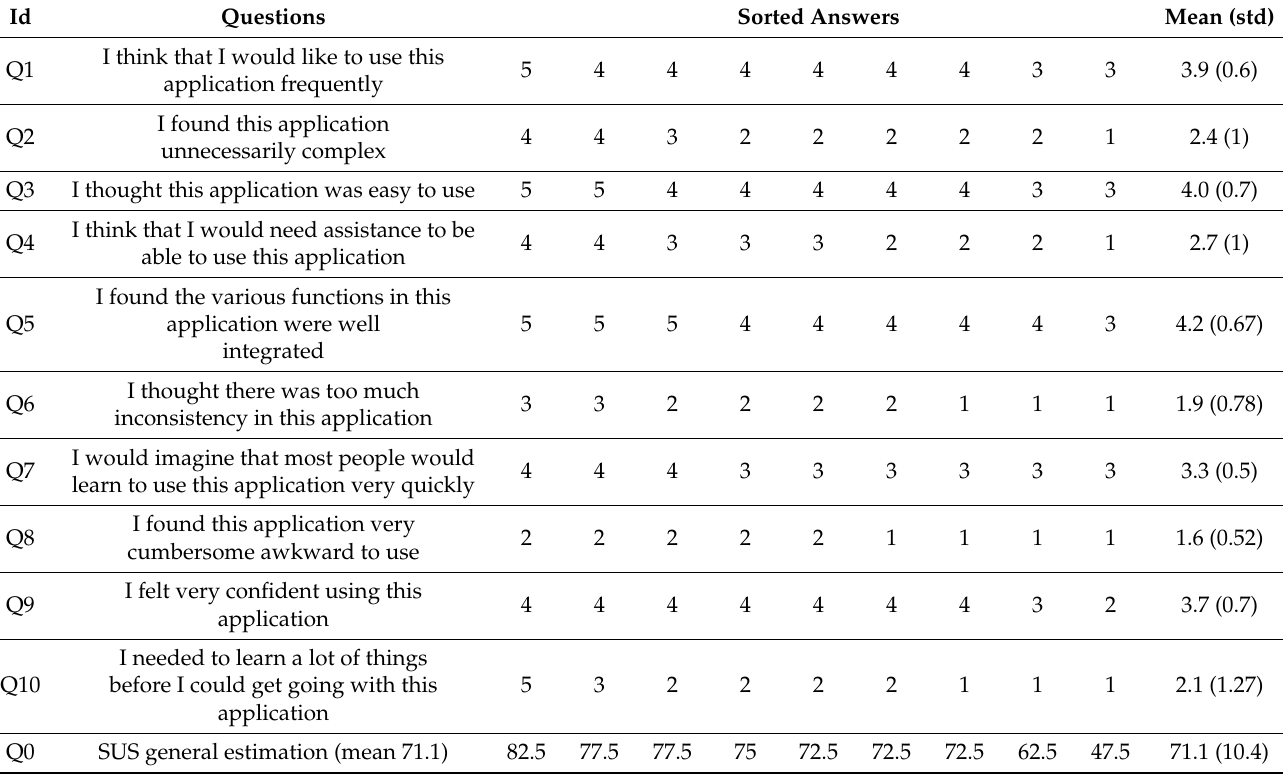
Table 4. SUS questionnaire’s answers sorted in decreasing